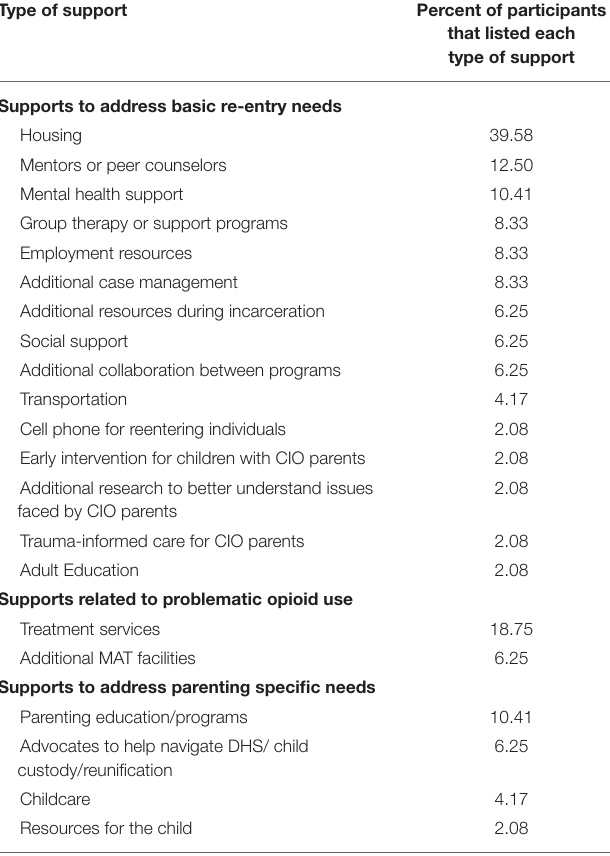
TABLE 2 | Needed supports for CIO